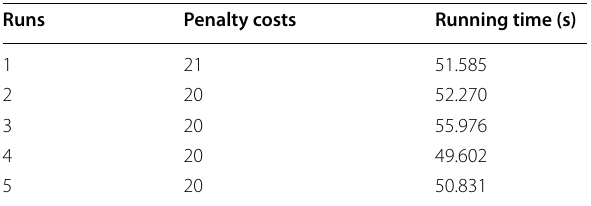
Table 6 Obtained optimal or near-optimal solutions for case study